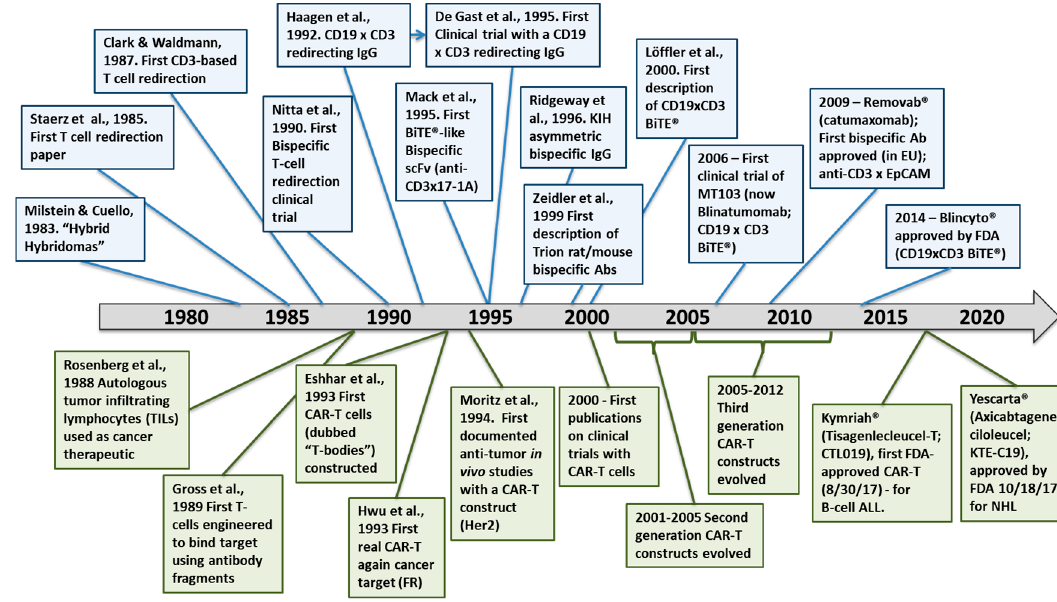
Figure 2. Key milestones in the history of T-cell redirected bispecific antibodies (TRBAs; top) and chimeric antigen receptor (CAR)-T cell (bottom) therapeutics. Specific references cited for TRBAs are: Milstein and Cuello, 1983 [38], Staerz et al., 1985 [41], Clark and Waldmann, 1987 [48], Nitta et al.,